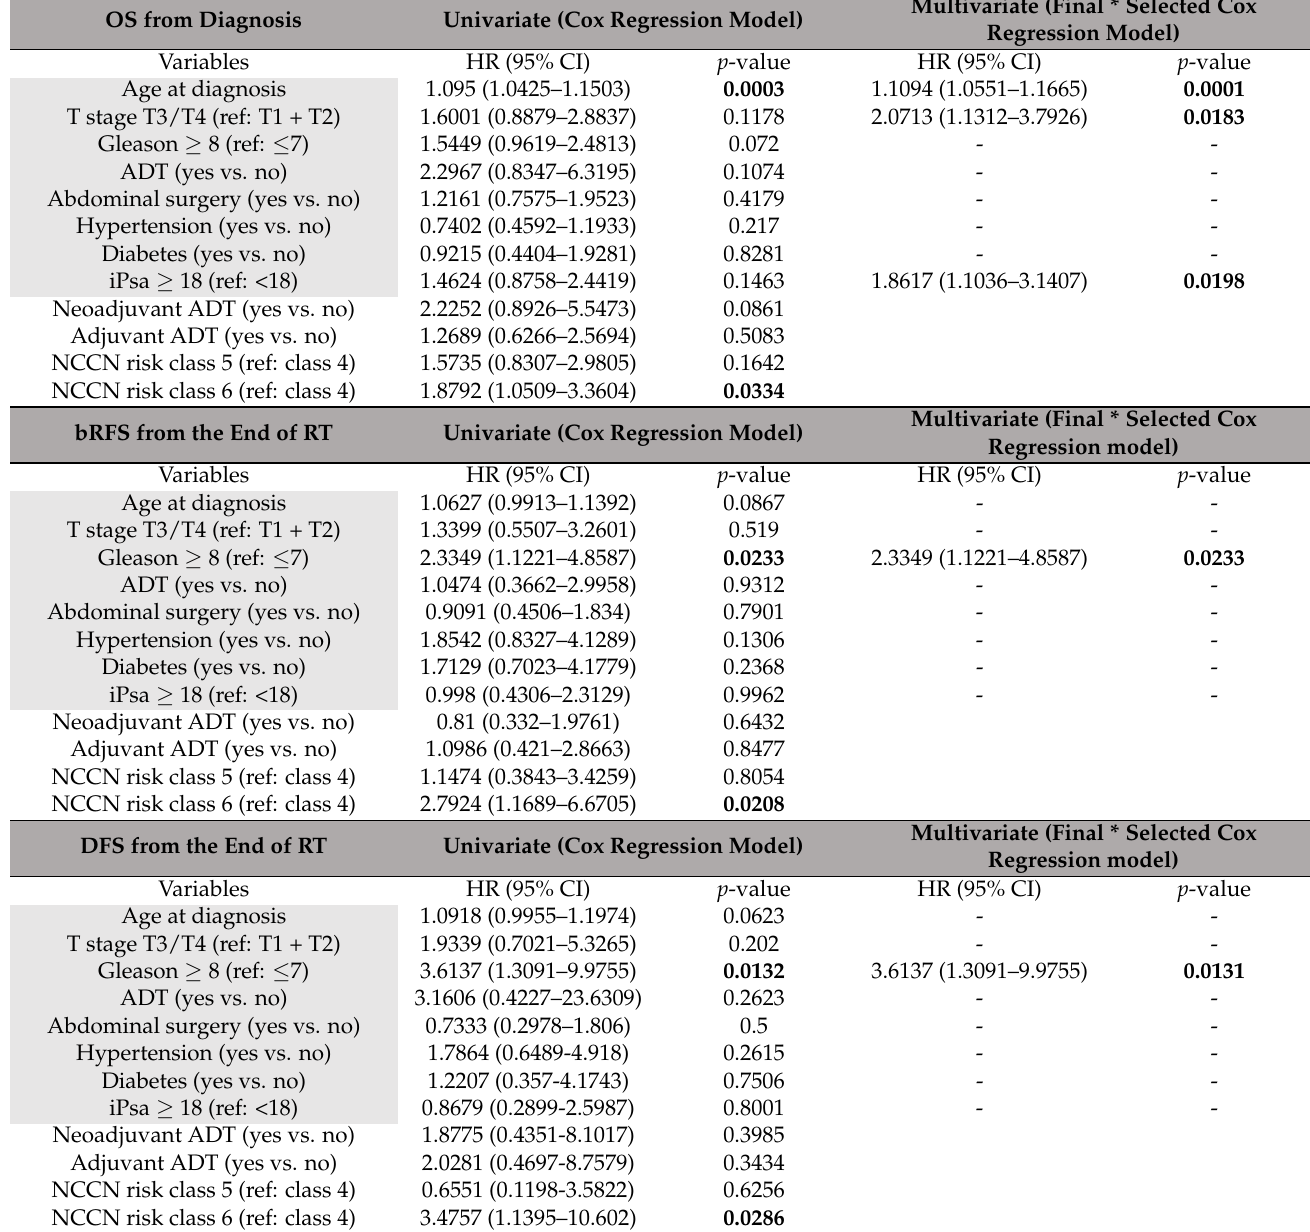
Table 3. Univariate and multivariate analysis of factors influencing